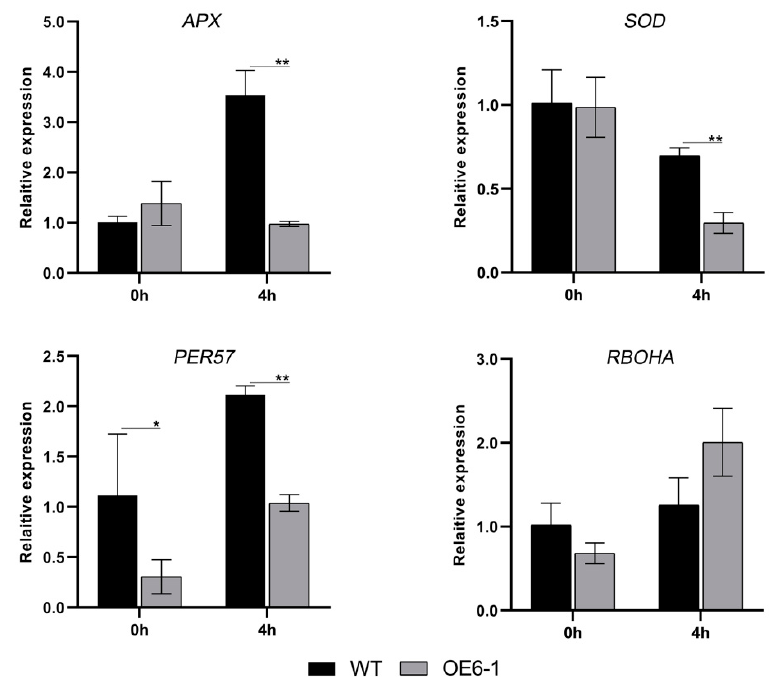
Figure 9. Expression patterns of ROS-related genes regulated by CbWRKY27 under salt treatment. Ascorbate peroxidase ( APX ), SUPEROXIDE DISMUTASE ( SOD ), peroxidase 57 ( PER57 ), and respiratory burst oxidase homologue A ( RBOHA ). The qPCR data were normalized to the internal control expression of CbActin . The 2 − ∆∆ Ct method was used to evaluate the quantitative variation between the examined replicates. The data represent the means ± SD ( n = 3), * p < 0.05 and ** p < 0.01 using Student’s t -test. The six-week-old seedlings were subjected to 300 mM Nacl treatment.